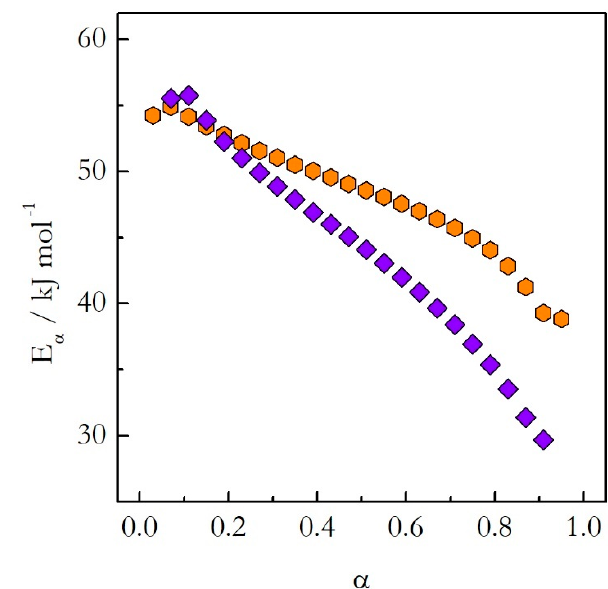
Figure 5. The activation energy as a function of conversion for the stoichiometric polymerization of DGEBA and m-PDA evaluated on heating (orange hexagons) and cooling (violet diamonds) [22,23]. Adapted from Ref. [22] with permission from Wiley.